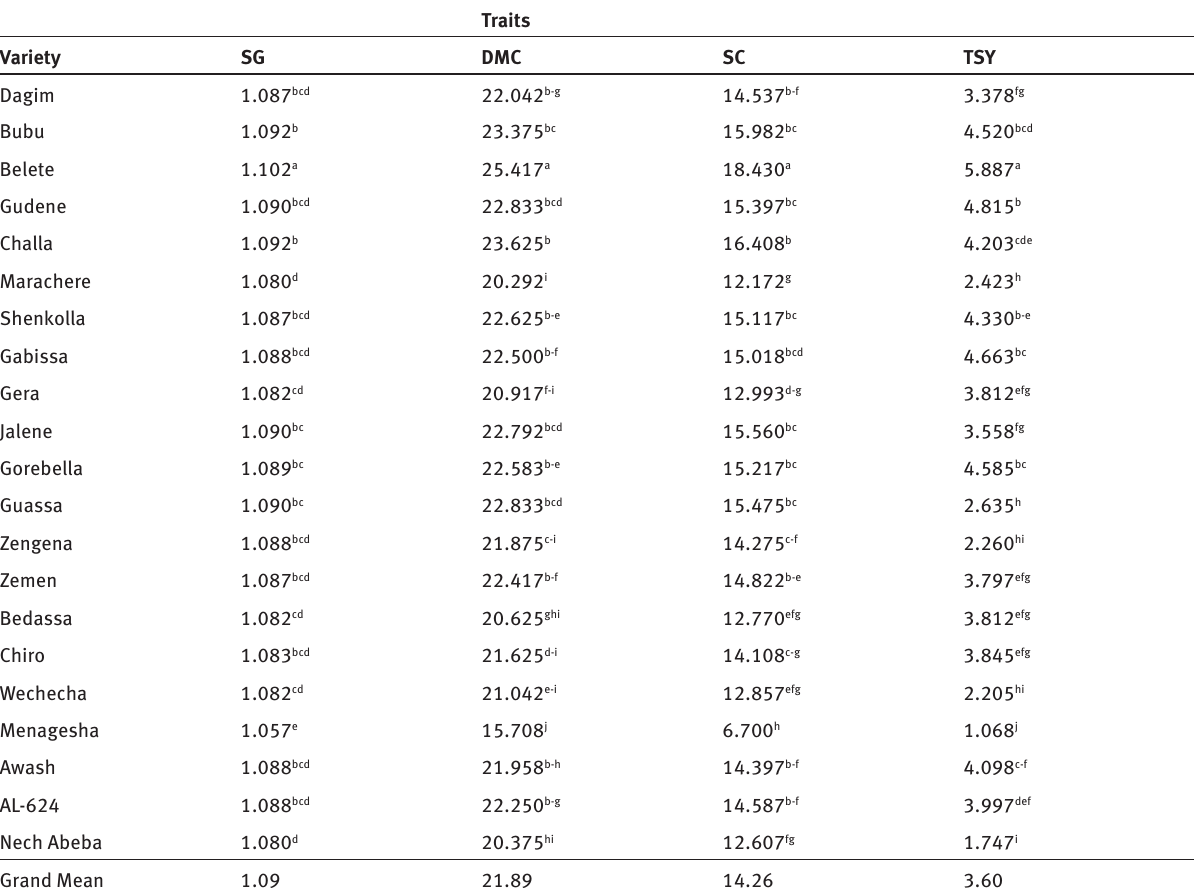
Table 6: Mean performances of 21 potato varieties for tuber quality traits evaluated at Holetta and Adea Berga in 2017